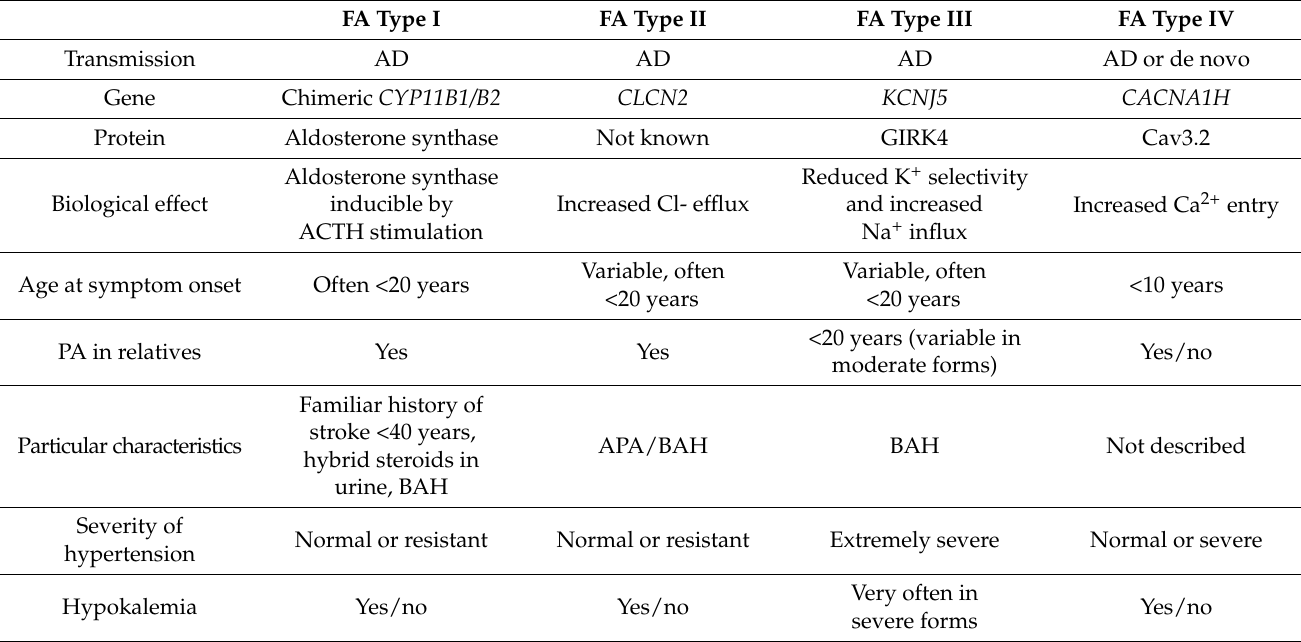
Table 2. Characteristics of familiar